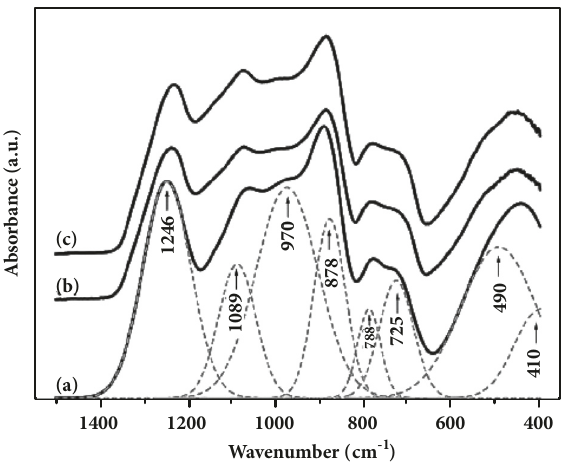
Figure 9: FT-infrared absorption spectra of (a) 0.5%, (b) 2%, and (c) 5% CeO 2 -doped glasses.